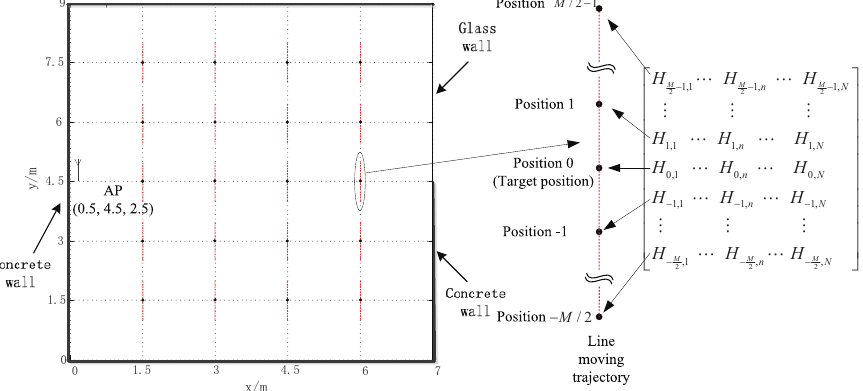
Figure 2. The 2-dimension layout of the indoor WLAN